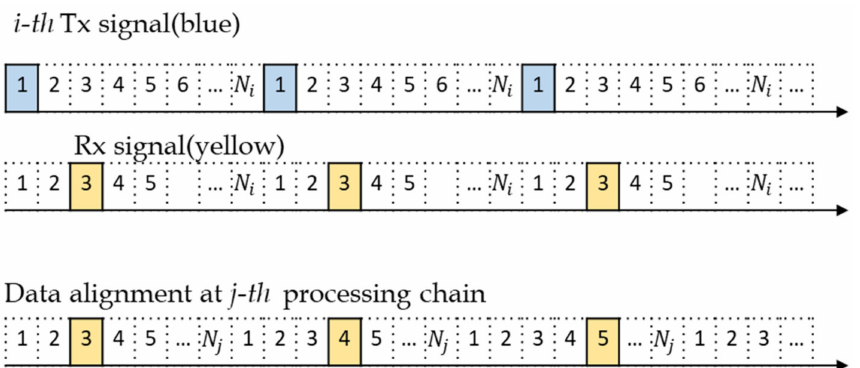
Figure 3. Reflected pulse of the i -th transmit signal and data alignment at the j -th processing chain when ∆ N = 1 and R 1 =